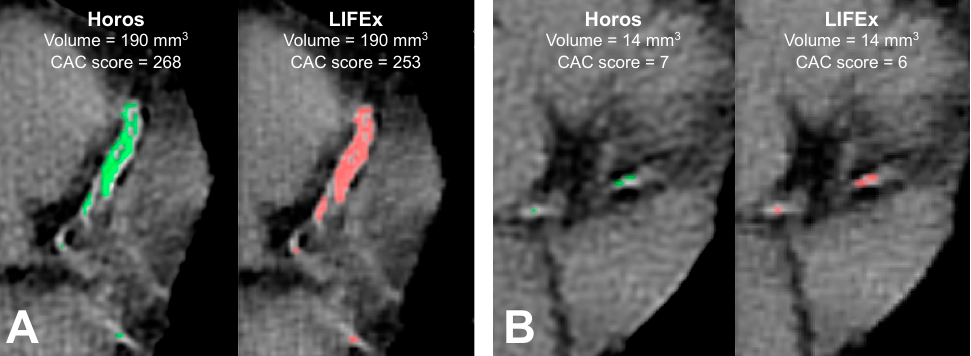
Figure 4. Comparison between coronary calcifications in two patients ( A , B ), obtained by Horos (green) and LIFEx (red) software. Patient A is a 70-year-old man with a prostatic tumor. Patient B is a 64-year-old man with a prostatic tumor. For each patient, coronary calcifications have the same volume and different CAC scores, as calculated by Horos and LIFEx.